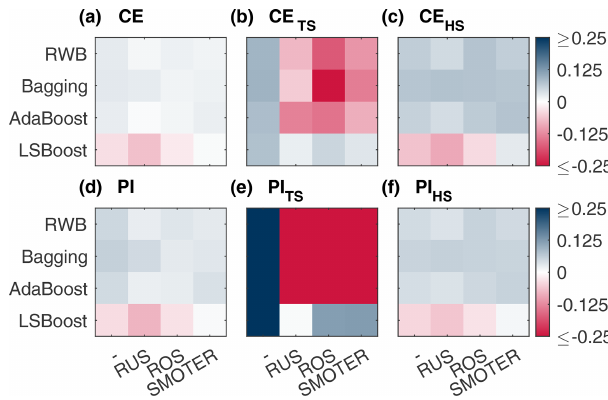
Figure 10. Change in (absolute) performance of CE (a) , CE TS (b) , CE HS (c) , PI (d) , PI TS (e) , and PI HS (f) produced by combinations of resampling (listed along the x axis) and ensemble (listed along the y axis) methods for the Don River